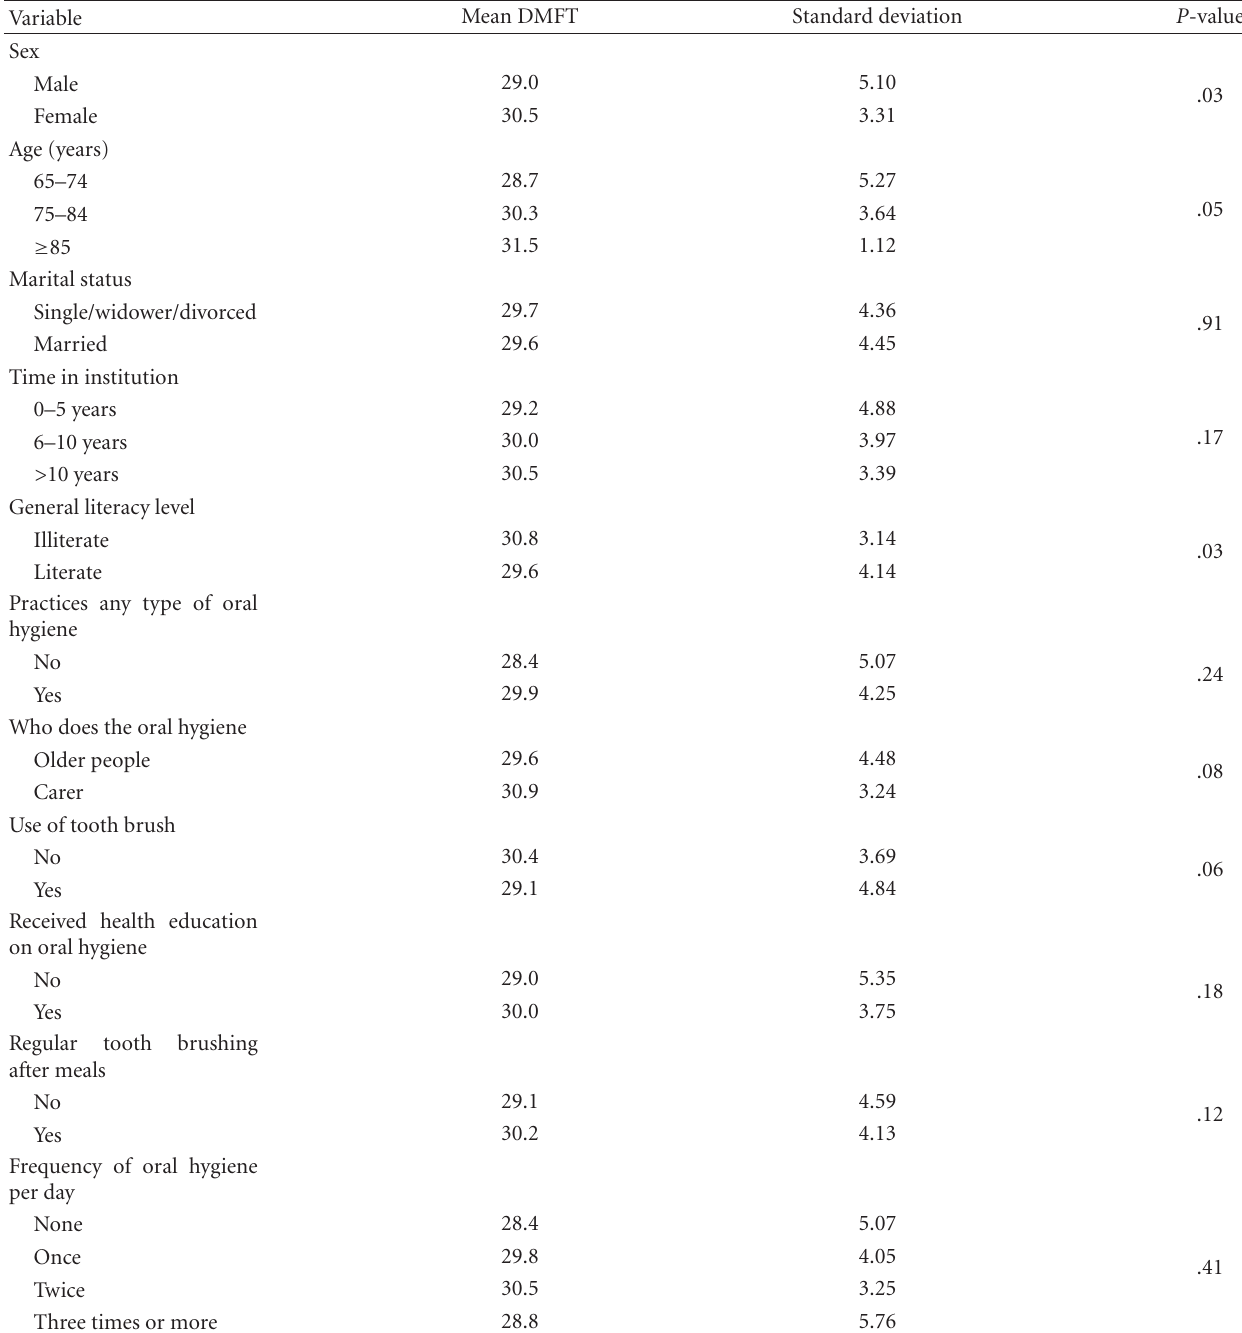
Table 3: Bivariate analysis of variables associated with the number of decayed, missing, and filled teeth (DMFT) in institutionalized older people in northeast